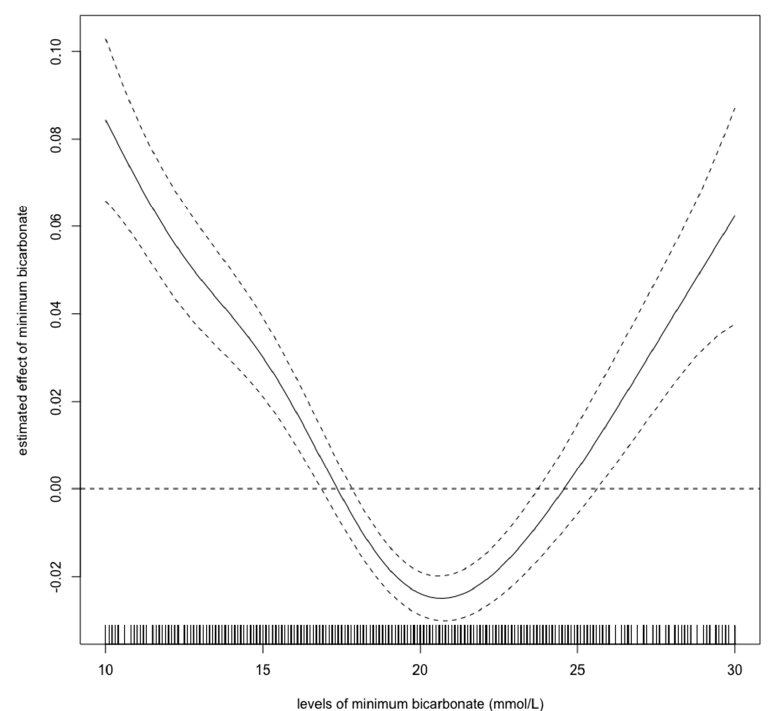
Figure 4. Nonlinear relationship between the bicarbonate level (mmol / L) and 28-day mortality in critically ill children with acute kidney injury. The curve: estimated spline function in log odds ratio on the effect of the bicarbonate level. The dotted lines: 95% confidence interval.